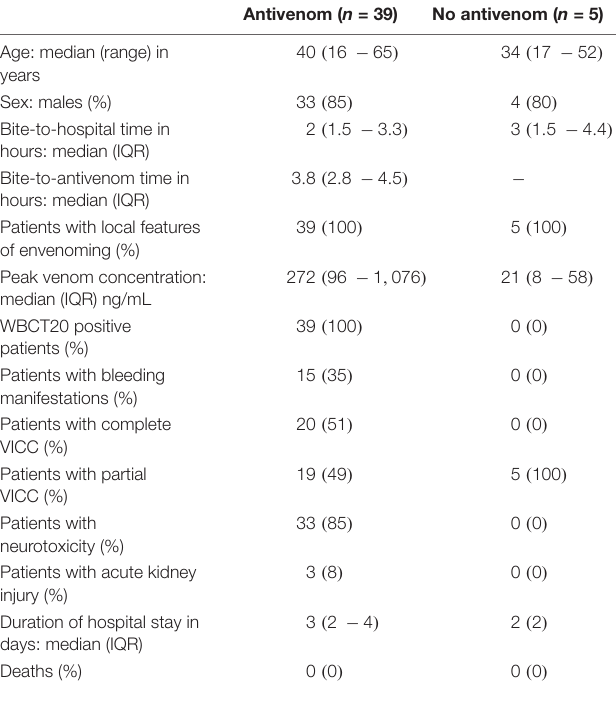
TABLE 1 | Comparison of the clinico-epidemiological data of the patients with venom-induced consumption coagulopathy following Russell’s viper envenoming recruited for this study: patients who received antivenom (antivenom) and who did not receive antivenom (No antivenom). Antivenom ( n =